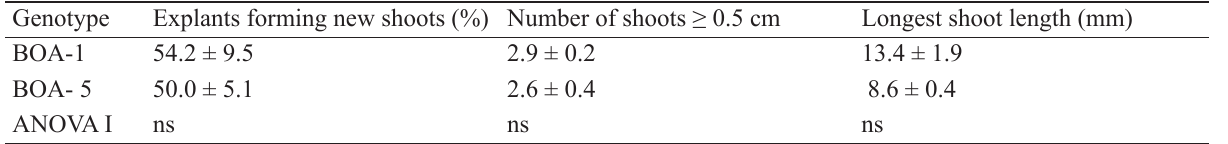
Table 1. Effect of genotype on the shoot proliferation of Quercus ilex. For each genotype, data represent means ± standard error (SE) of 48 shoots. ns: not